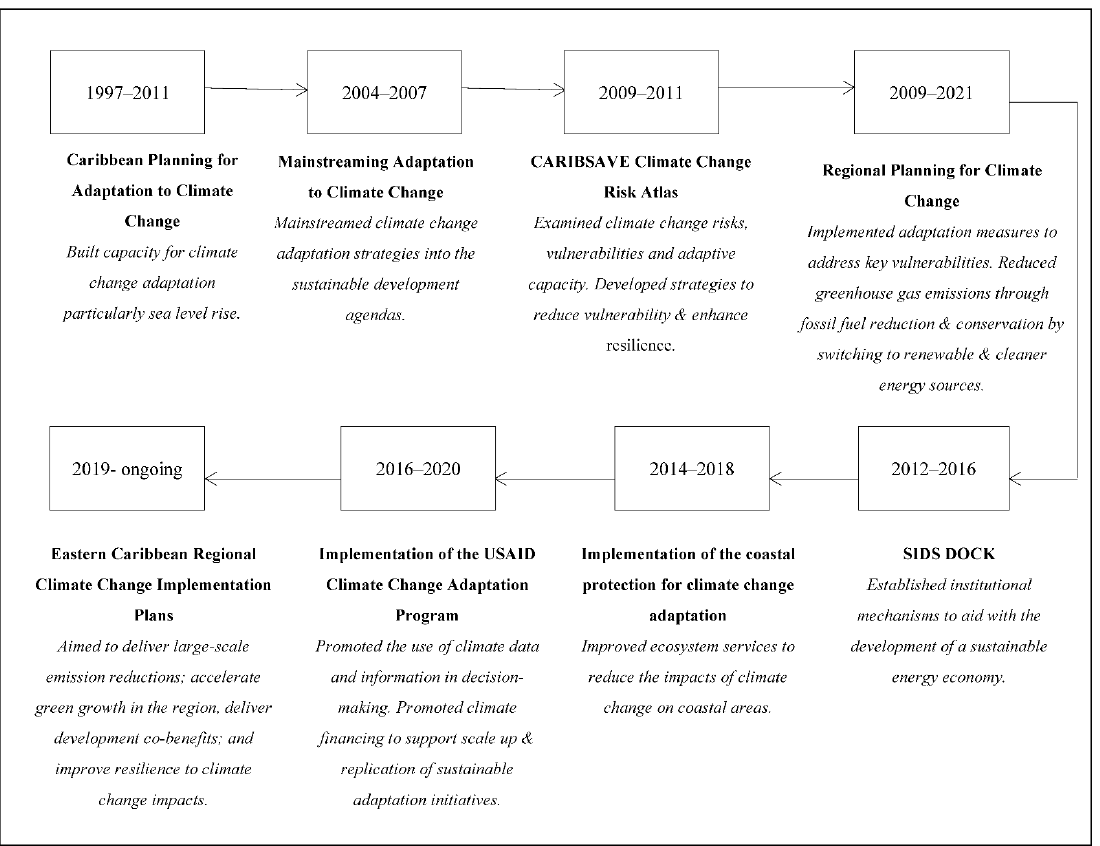
Figure 1. Eight major climate change adaptation and mitigation on going and implemented in the Caribbean.